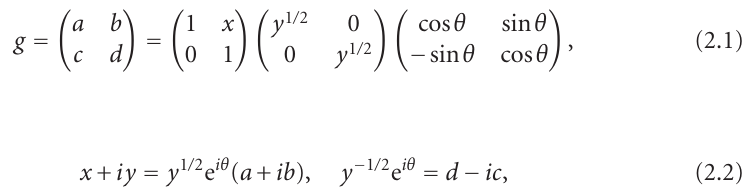
for t k , γ , k = 1,2, in the ( ψ , θ ) coordinates of 0 0